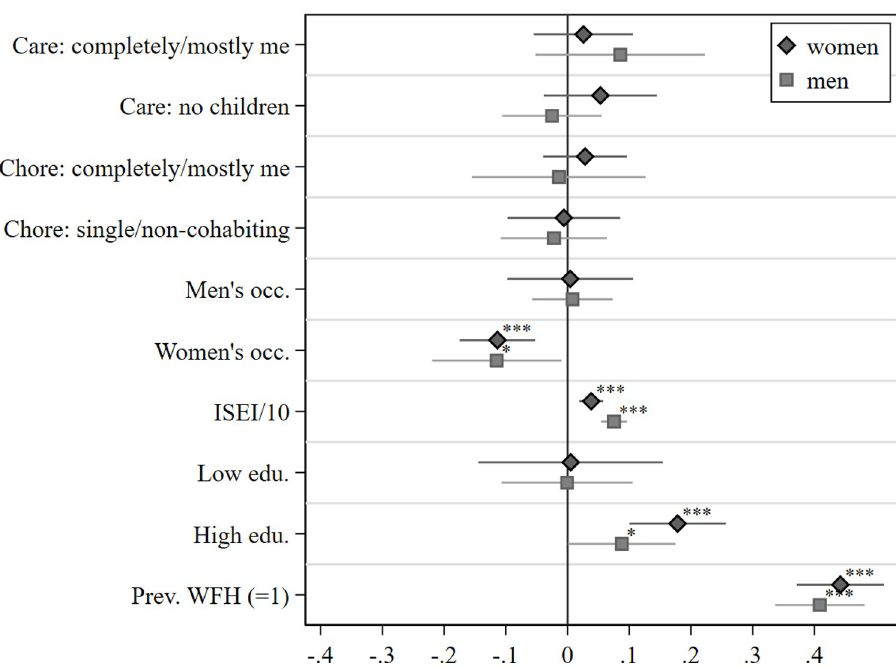
Fig 3. Work from home regressed on family responsibilities, occupational characteristics, education, and WFH prior to COVID-19. Note: Plot of Linear Probability Model coefficients (see S3 Table for the full models). Based on pairfam -COVID-19 survey and pairfam , release 12.0, and a special evaluation of the German LFS 2019, not weighted. Reference groups: Care: split even/mostly partner/completely partner; Chore: split even/mostly partner/completely partner; mixed occupation; intermediate education. Controls (not shown): enrolled in education, East, migration background, rural, cohorts. + p < 0.10 � p < 0.05, �� p < 0.01, ��� p < 0.001.